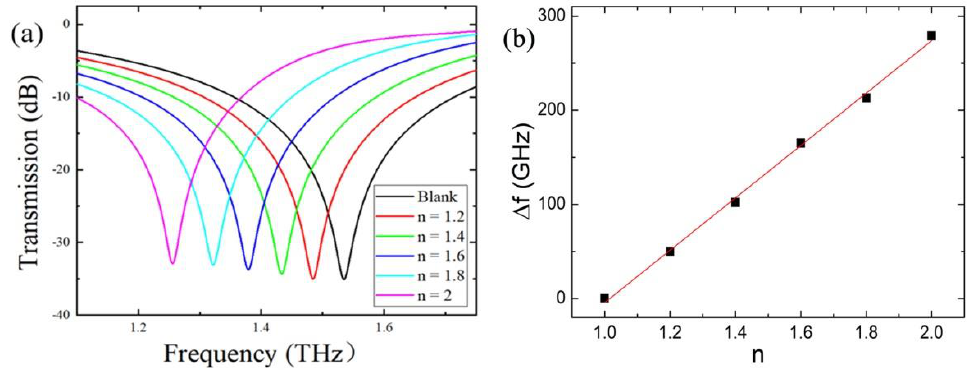
Figure 2. ( a ) Transmission spectra of the sensor covered by analyte with different refractive indices; ( b ) Plot of ∆ f vs. n with the red line being the fitting line.